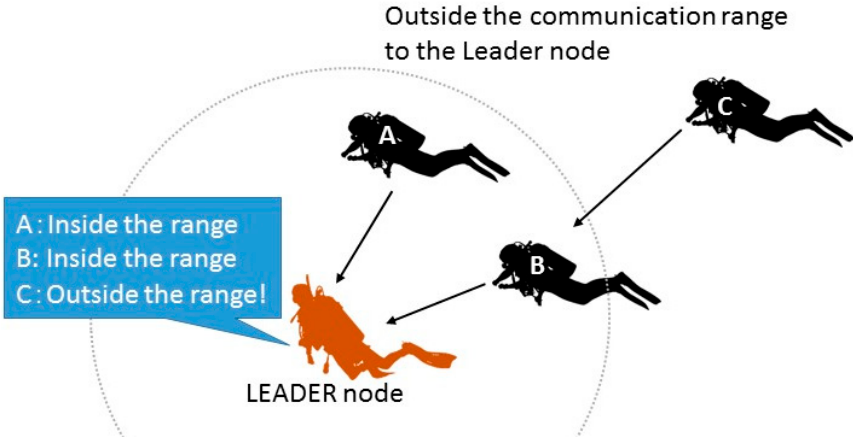
Figure 2. Assumed usage. Figure 2. Assumed